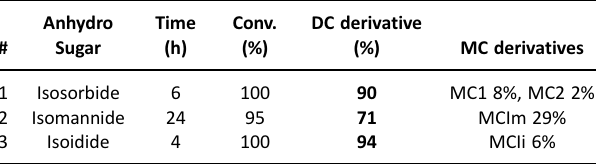
Table 3. Carboxymethylation of isomannide and isoidide.